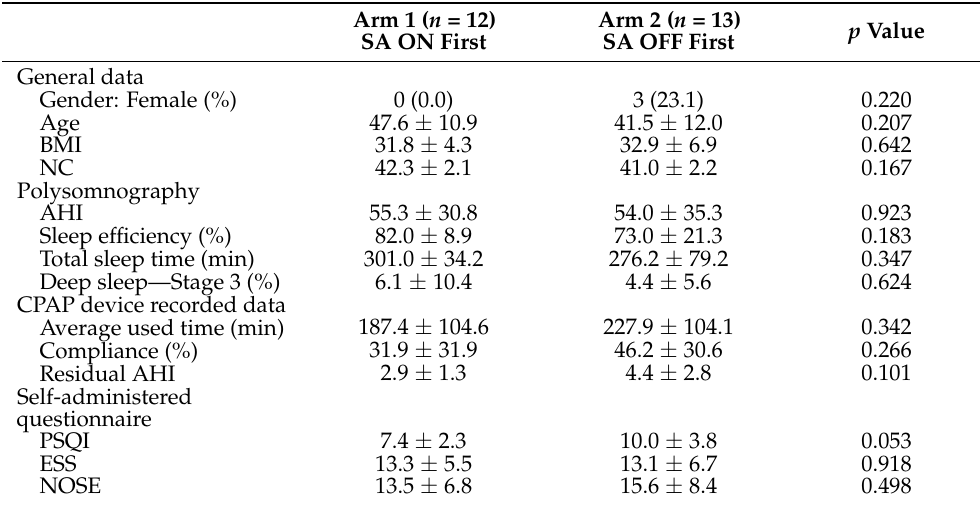
Figure 1. Patient flow diagram. Thirty-five patients were enrolled in the study and were randomized. Ten withdrew and 25 patients completed the crossover study. OSA = obstructive sleep apnea, CPAP = continuous positive airway pressure, SA = SensAwake TM . Table 1. Baseline data between the two arms.